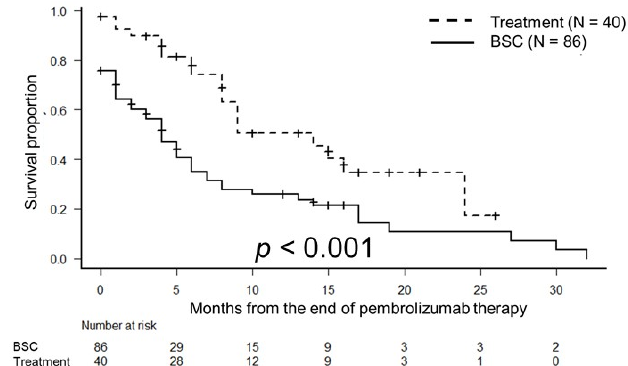
Figure 2. Kaplan–Meier estimates of progression-free survival (PFS) in patients with metastatic urothelial carcinoma who received third-line therapy (treatment group) and those who did not receive third-line therapy (BSC group). The median PFS times were 14 months in the treatment group and 4 months in the BSC group ( p < 0.001).